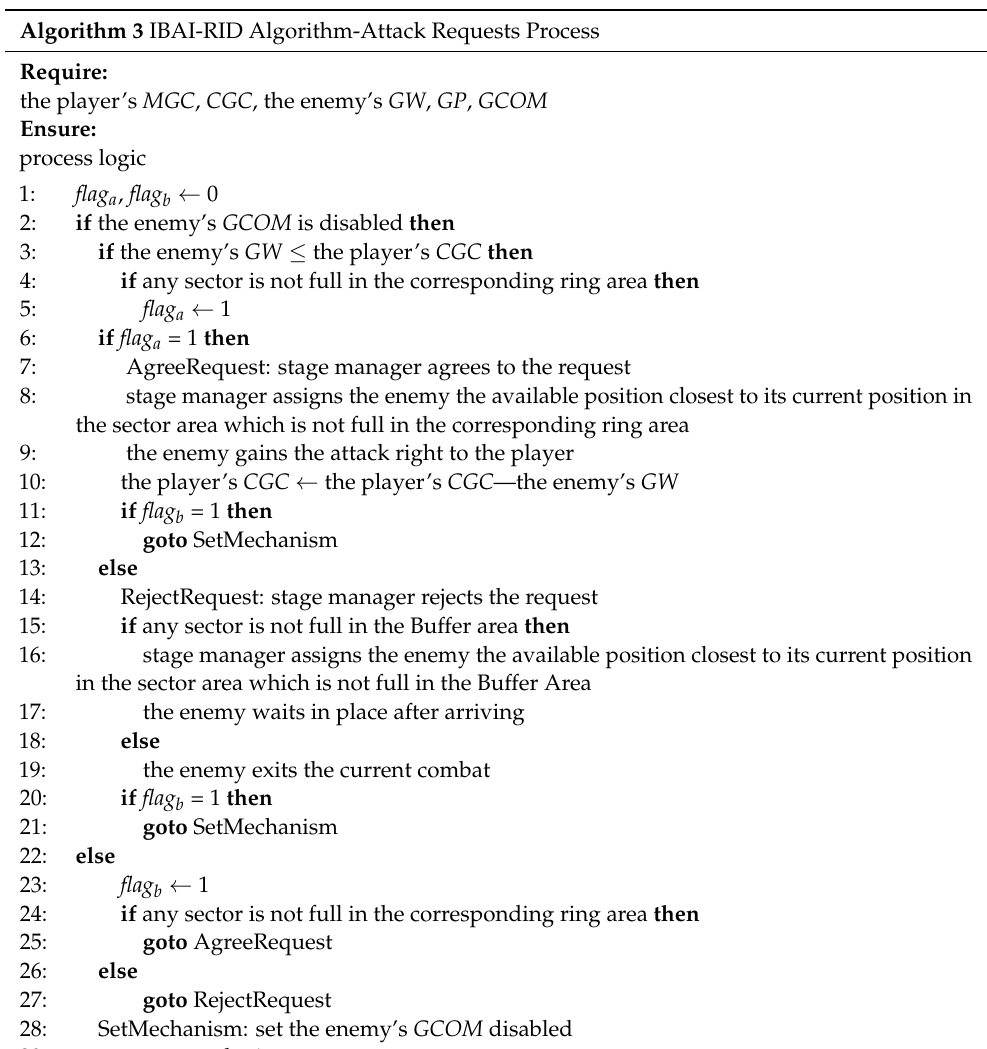
Algorithm 3 IBAI-RID Algorithm-Attack Requests